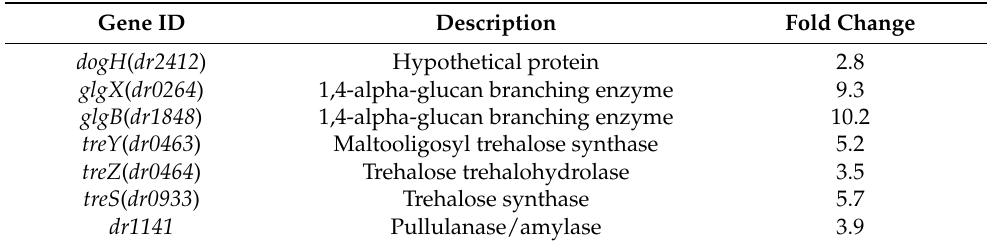
Figure 4. GC-MS quantitative analysis of carbohydrate metabolites in D. radiodurans . ( A ) Without sorbitol treatment; ( B ) with 1.0 M sorbitol stress treatment for 3 h. WT: wild-type strain; ∆ dogH : dogH -deleted mutant. One-way ANOVA and Dunnett’s multiple-comparison test; A probability value of p ≤ 0.05 was considered significant. Data are presented as averages ± SEM. ****: p ≤ 0.0001; **: p ≤ 0.01; and ns: non-significant. Table 1. Analysis of transcriptional expression of genes related to maltose and trehalose synthesis pathways.